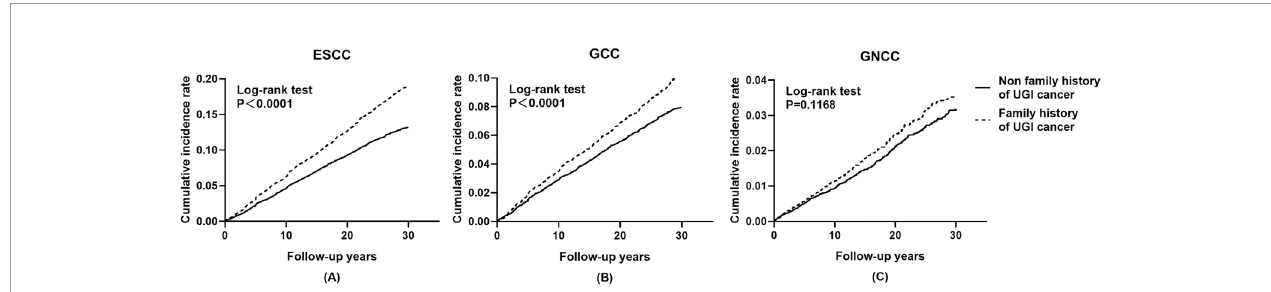
FIGURE 1 | Effect of family history of UGI cancer on cumulative incidence caused by ESCC (A) , GCC (B) , and GNCC (C) . ESCC, esophageal squamous cell carcinoma; GCC, gastric cardia carcinoma; GNCC, gastric non-cardia carcinoma.